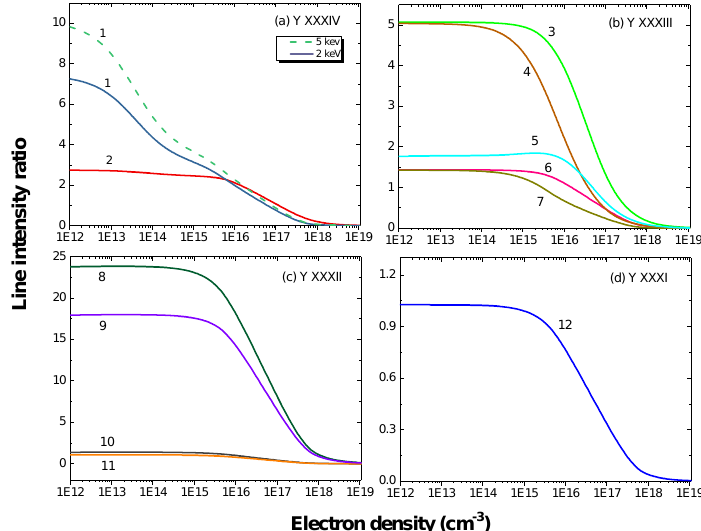
Figure 7. Density-sensitive line ratios for ( a ) C-like Y XXXIV, ( b ) N-like Y XXXIII, ( c ) O-like Y XXXII and ( d ) F-like Y XXXI. The number labels correspond to the line ratios: (1) 17.0632(7) nm/11.1236(9) nm at 5-keV electron energy (dash) and 2-keV electron energy (solid), (2) 17.0632(7) nm/8.4792(19) nm, (3) 17.8665(6) nm/9.9054(10) nm, (4) 14.8036(5) nm/9.9054(10) nm, (5) 12.0926(6) nm/9.9054(10) nm, (6) 17.8665(6) nm/8.8822(7) nm, (7) 14.8036(5) nm/8.8822(7) nm, (8) 13.8581(6) nm/19.4383(8) nm, (9) 16.2725(9) nm/19.4383(8) nm, (10) 16.2725(9) nm/7.2352(8) nm, (11) 13.8581(6) nm/7.2352(8) nm and (12) 15.6801(11) nm/6.21115(14)